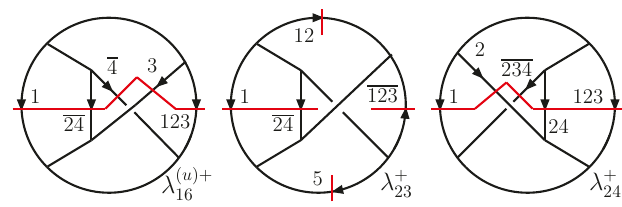
Figure 9 . Extra causal configurations of the u -channel of the N 4 MLT topology due to nonplanarity.